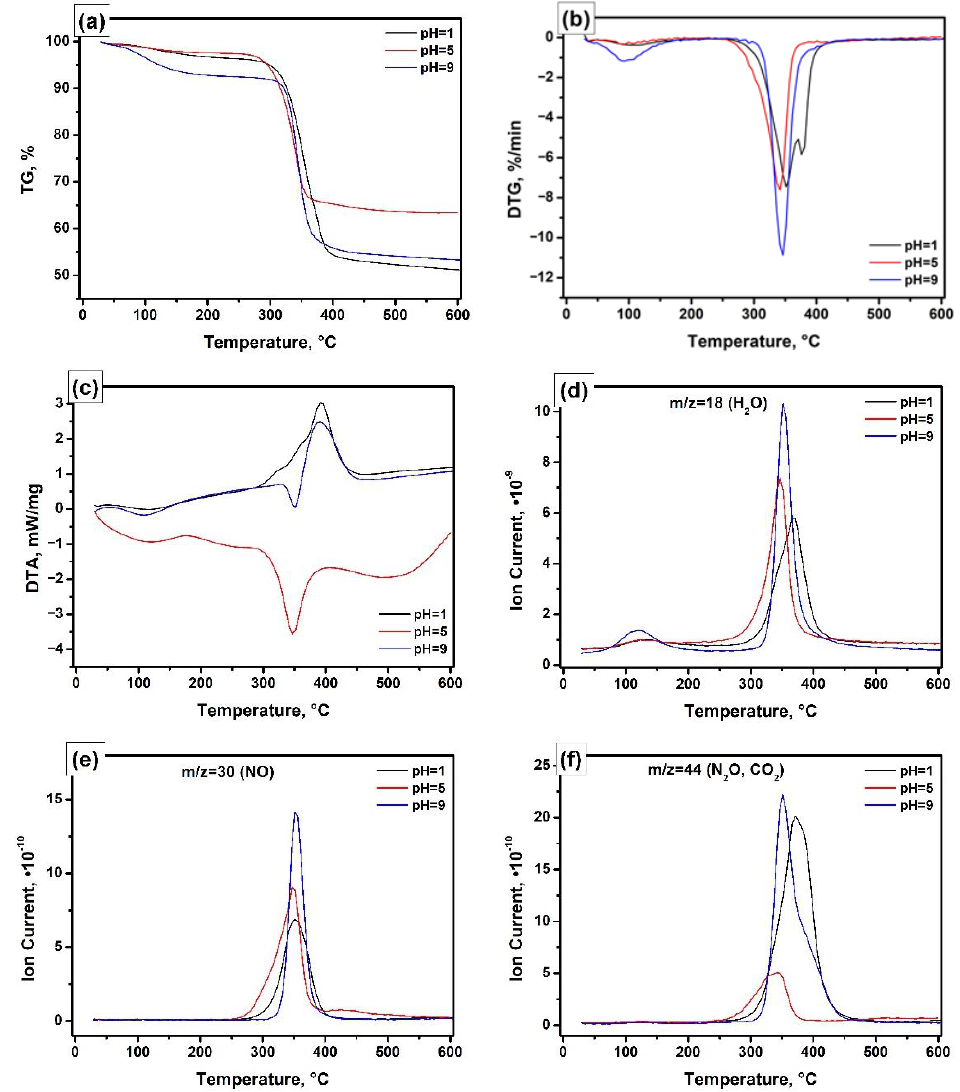
Figure 1. Thermal analysis of the Ni-Mg-OH samples prepared at various pH: ( a ) TG; ( b ) DTG; ( c ) DTA; ( d – f ) mass-spectrometry data. ( c ) DTA; ( d – f ) mass-spectrometry